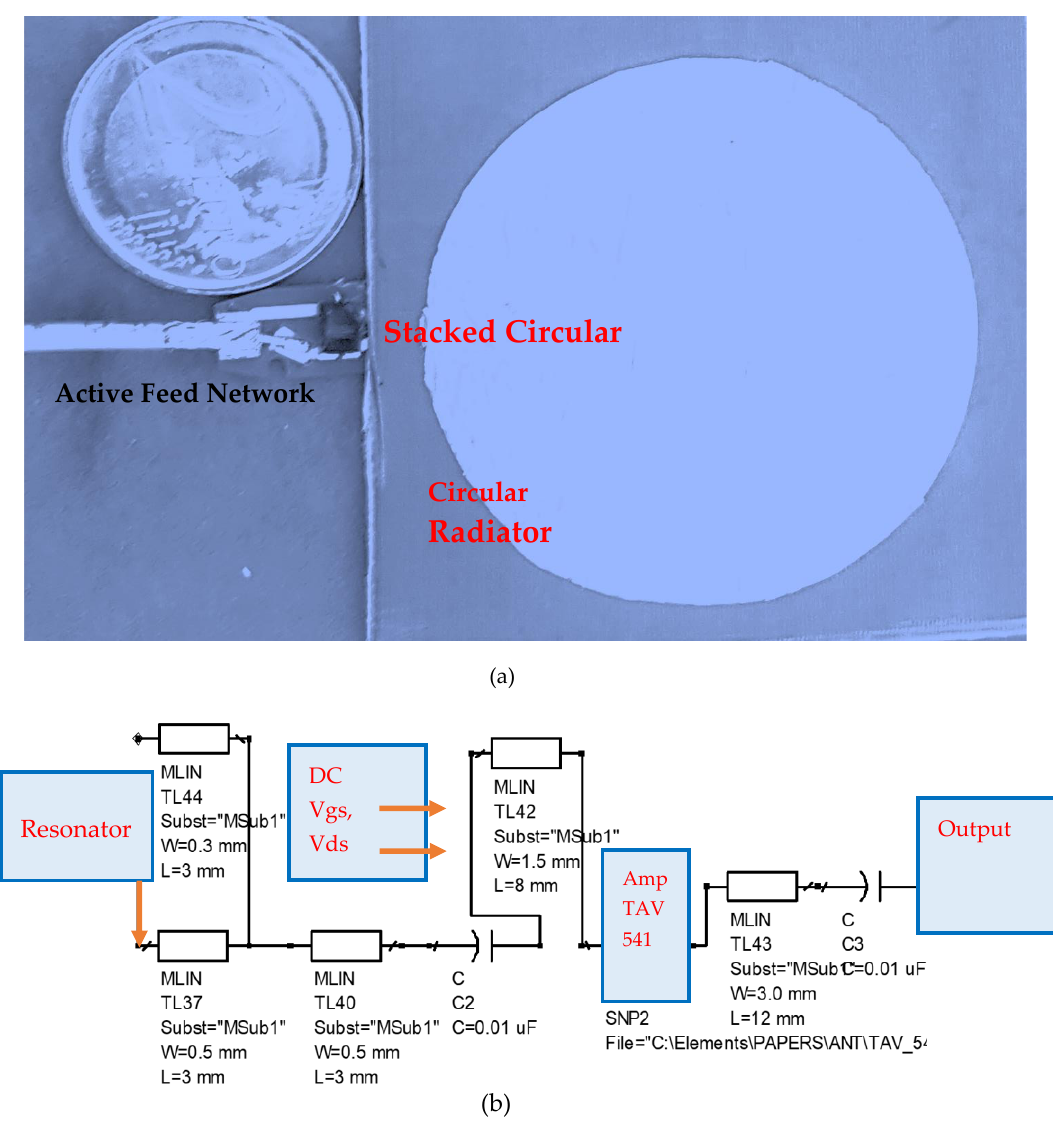
Figure 25: a. A photo of a prototype of the Active Stacked Circular Patch b. Antenna layout Figure 25. ( a ) A photo of a prototype of the Active Stacked Circular Patch; ( b ) Antenna